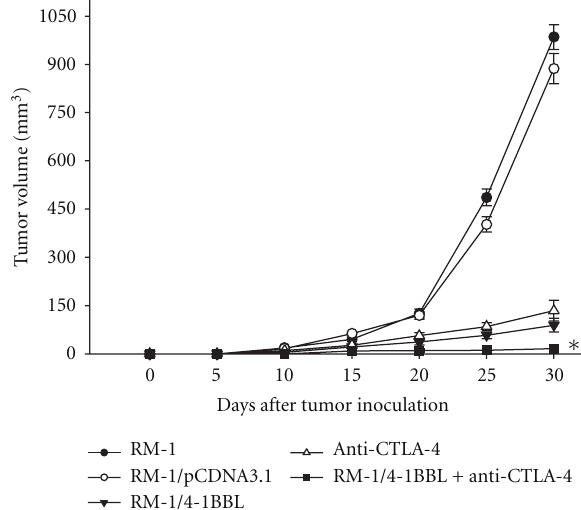
Figure 2: Antitumor immunity in vivo . Mice were challenged subcutaneously with RM-1 cells (2 × 10 5 cells/mouse), then 10 6 tumor vaccine cells (RM-1, RM-1/pCDNA3.1, RM-1/4-1BBL) were immunized at the same day, with 9H10 or control hamster IgG intraperitoneally every 3 d. The data are expressed as means ± SD of three replicates ( ∗ P < 0 . 05).